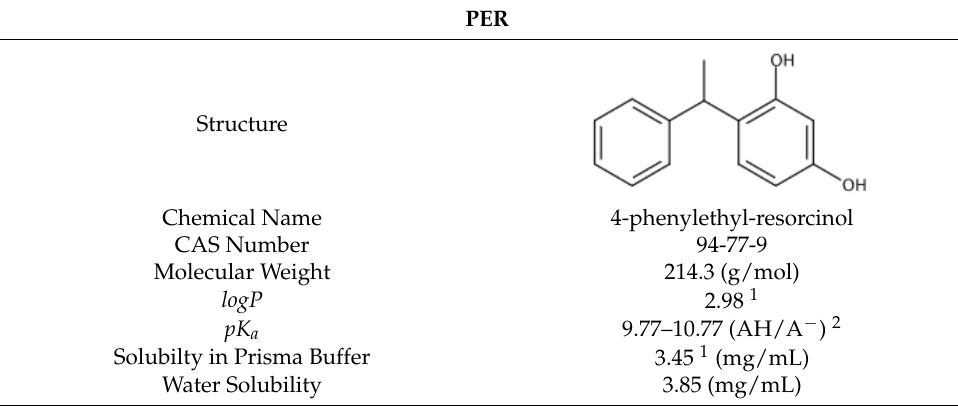
Table 1. Chemical structure and physico-chemical properties of PER. PER